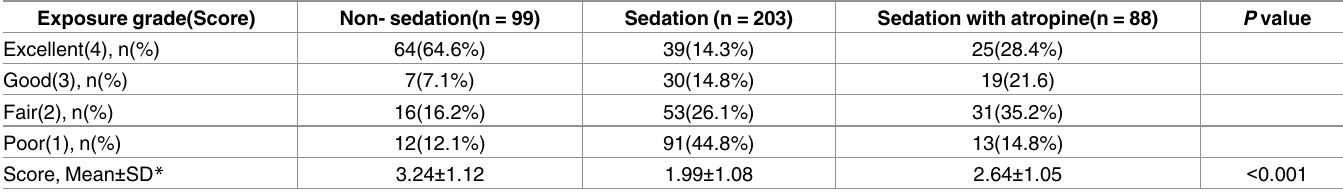
Table 3. Observed esophagogastric junction region exposure grade and score.